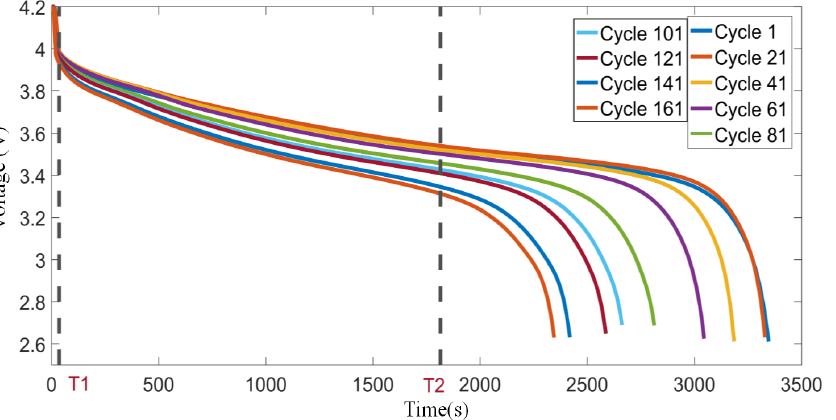
Figure 8. Output voltage of constant discharge of NASA battery No. 0005 at different cycle